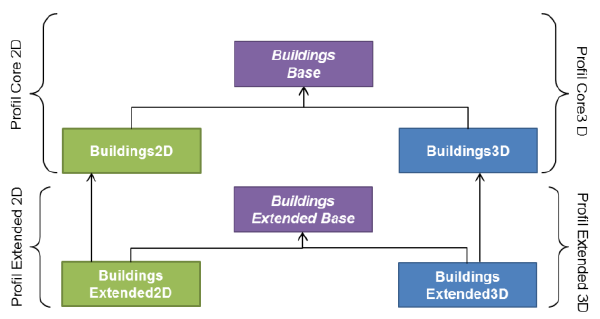
Figure 8. Profiles of the INSPIRE specifcation for Building Models. Figure modified from (Gröger and Plümer,